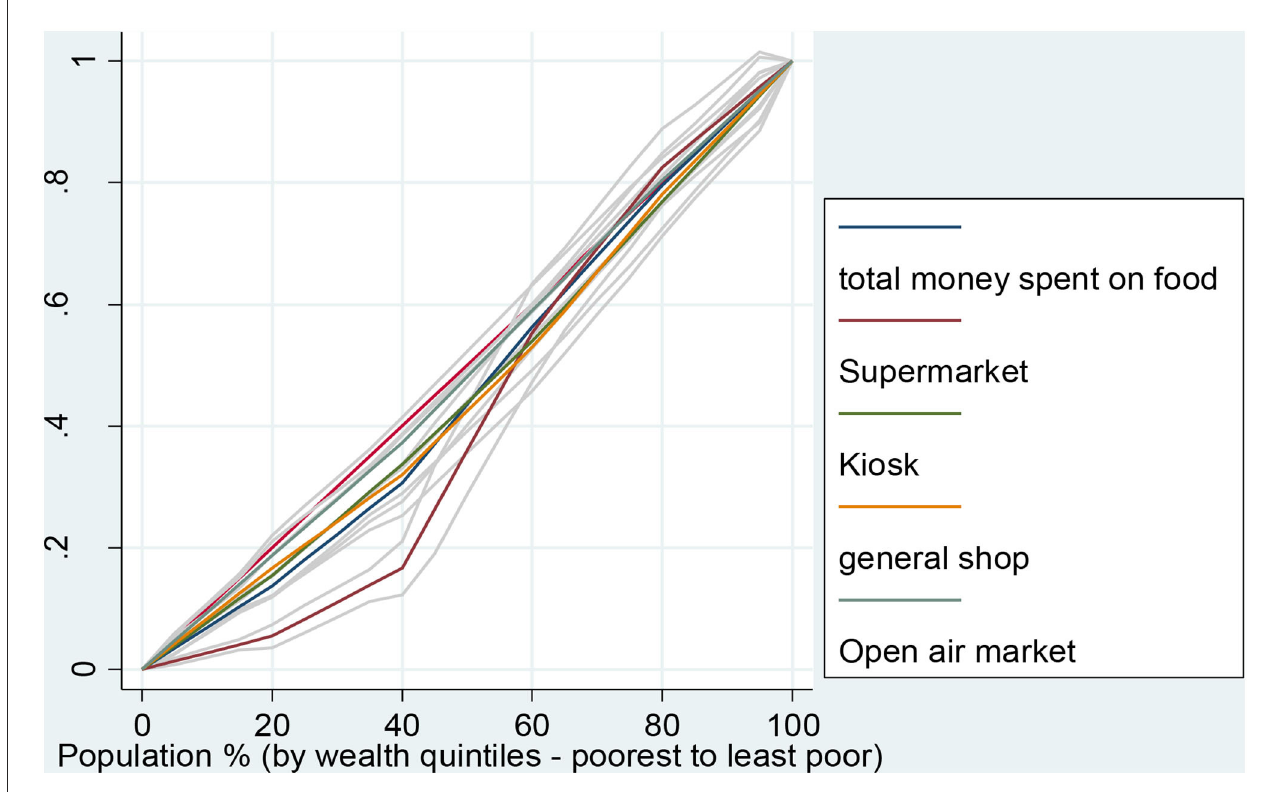
FIGURE2 Inequality of the amount of money used to purchase food in various outlets by household wealth quintiles.